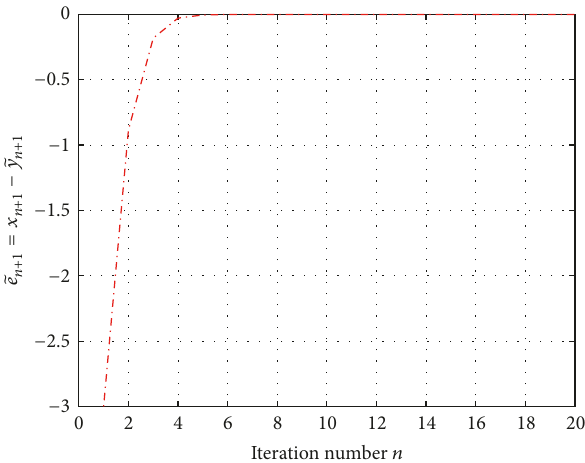
Figure 3: The trajectory of ̃𝑒 𝑛+1 with 𝜇 = 0.78 and 𝑘 𝑖 = 0.49 .